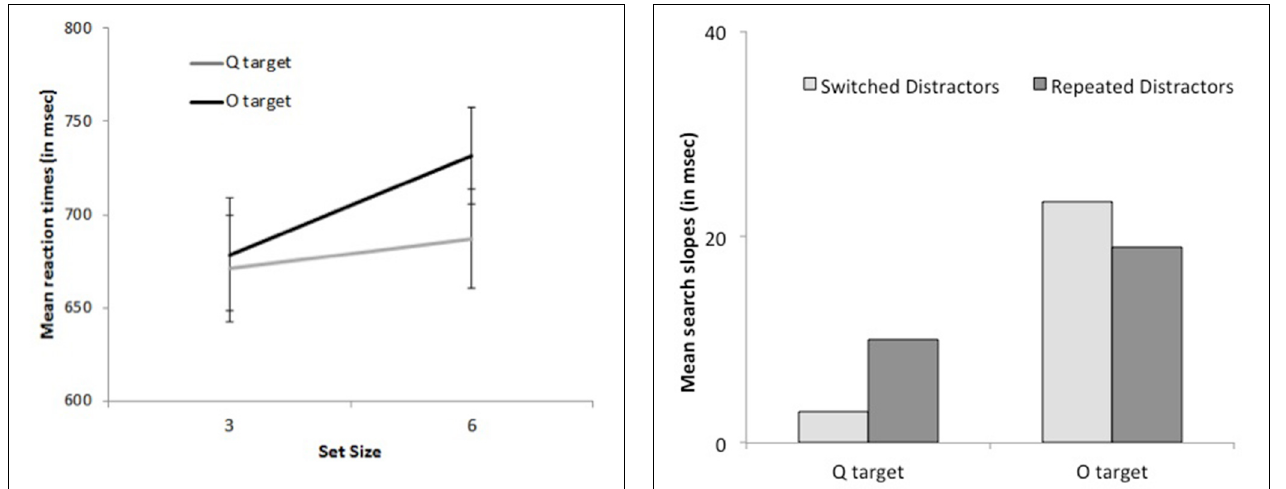
FIGURE 4 | Mean reaction times on target-present trials for set size 3 and 6 as a function of target shape (O and Q) in Experiment 2. FIGURE 5 | Mean search slopes (mean additional reaction time for each added distractor) on target-present trials preceded by